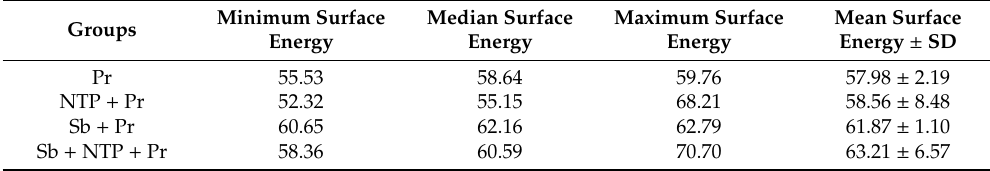
Table 3. Minimum, median, maximum, and mean surface energy values (mJ / m 2 ) and standard deviations (SD) for each group.